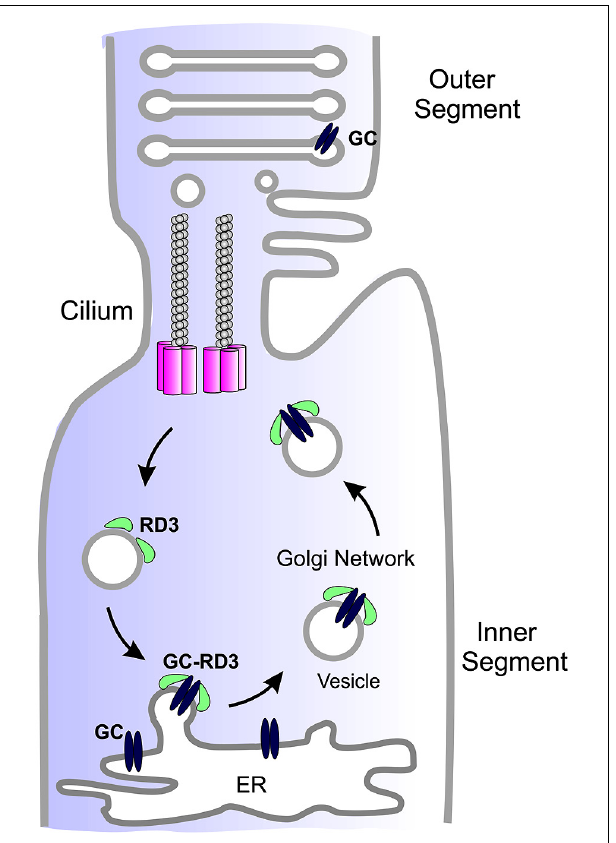
FIGURE 2 | Simplified diagram showing the role of RD3 in GC trafficking. GC synthesized in the endoplasmic reticulum (ER) of photoreceptor inner segments binds to RD3 on the cytoplasmic side of the ER membrane.This interaction may induce membrane curvature required for the budding of GC-RD3 from the ER in the form of small vesicles. RD3 also inhibits the cyclase activity of GC.The RD3-GC complex together with other adaptor proteins is translocated through the Golgi to the base of the connecting cilium where GC perhaps in the absence of RD3 is transported through the cilium to the base of the outer segments where it is incorporated into disk membranes. At some point RD3 dissociates from GC possibly through phosphorylation or other post-translational modifications or protein–protein interaction. RD3 associated with endosomes is returned to the ER to initiate another cycle of RD3-mediated GC